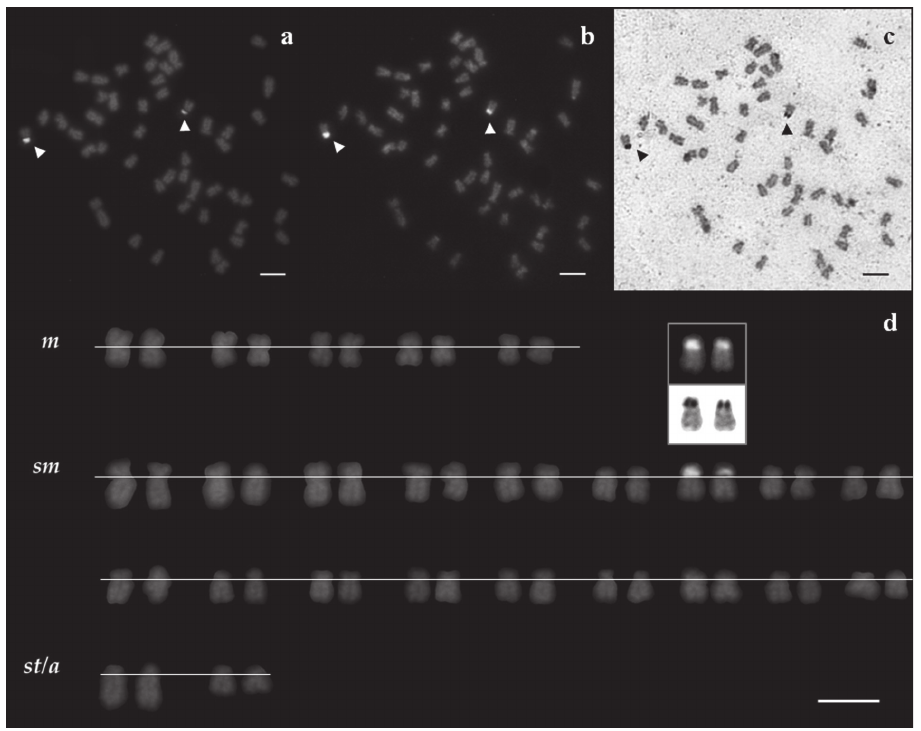
Figure 2. Metaphase spreads of a S. aradensis male, stained with sequential treatments a rDNA FISH b CMA -NOR, and c Ag-NOR treatments d corresponding karyotype of the same individual after rDNA 3 FISH, with CMA - and Ag-NOR signals inset. NORs are indicated by arrowheads. Scale bar = 3